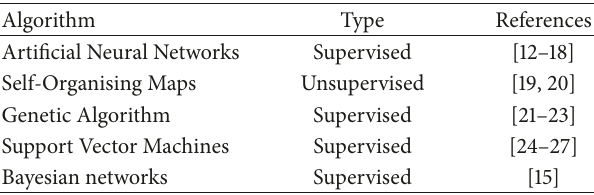
Table 1: List of relevant references in credit card frauds detection, based on data analysis and machine learning, organised according to the algorithm